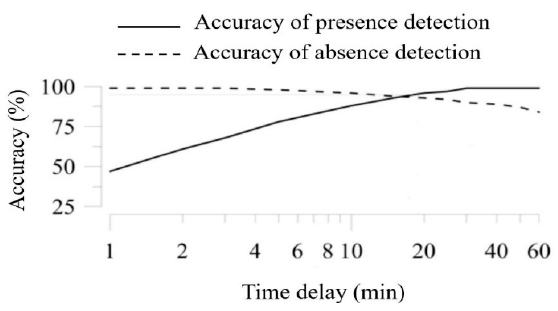
Figure 1. The influence of time-delay on accuracy of presence and absence detection from a case study—adapted from